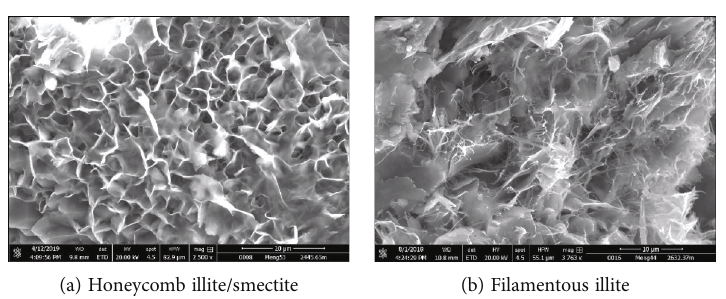
Figure 10: Scanning electron microscope image for samples of Chang 8